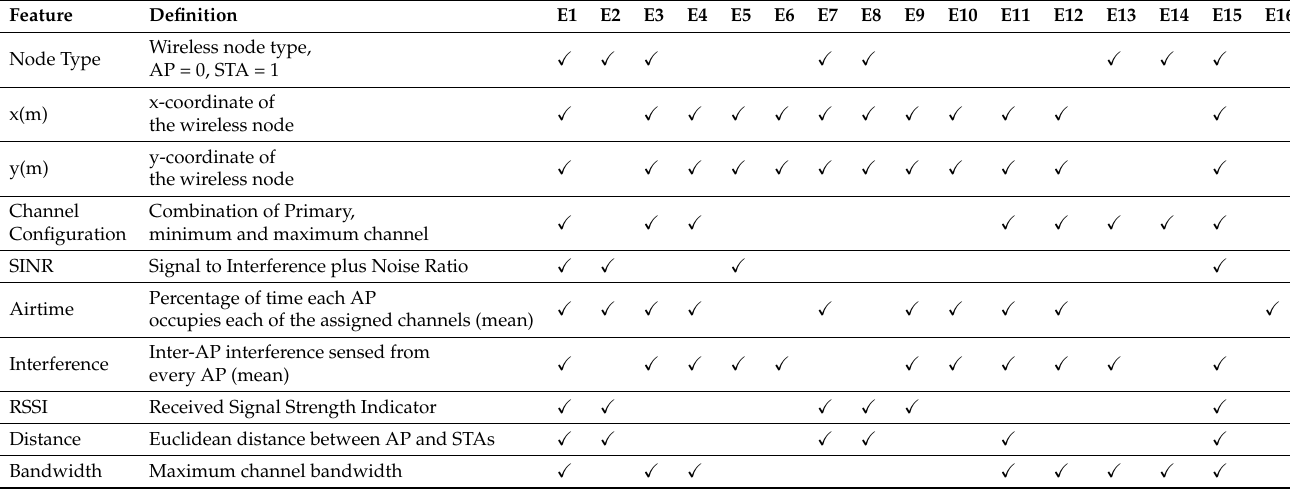
Figure 6. Correlation between features and throughput. Table 3. Features used per